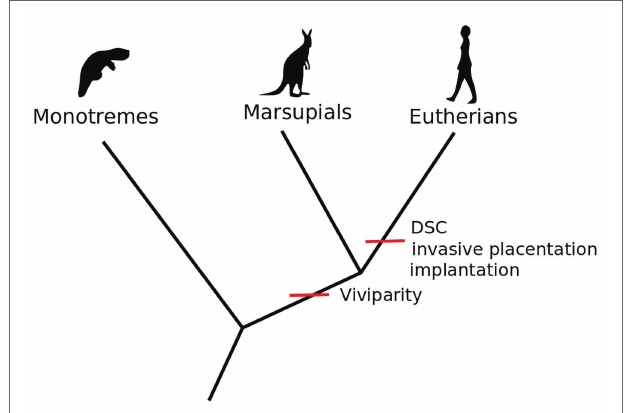
FIGURE 1 | Viviparity is a shared derived trait of marsupials and eutherians. Embryo implantation, invasive placentation, and decidual stromal cells (DSC) occur only in the eutherian lineage [Adapted from Wagner et al. (2019), Figure 1, p.